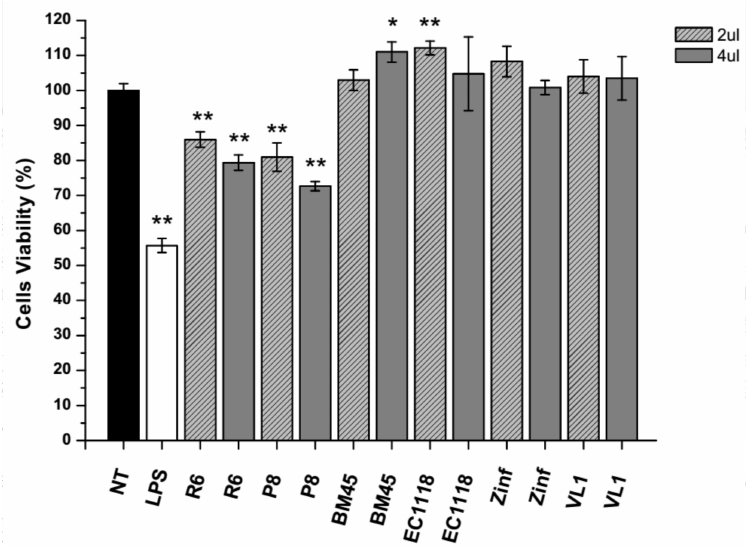
Figure 2. Effect of samples on cell viability. RAW 264.7 cells were treated with 2 and 4 µ L of the samples and subjected to an MTT test. Absorbance of formazan was determined at 595 nm and cell viability was reported as a percentage. A positive control ( (cid:3) ) was obtained by treating cells with lipopolysaccharide (LPS). Values from non-treated cells (NT) were used as a negative control ( (cid:4) ). Results are the mean of three different experiments performed in duplicate. Bars indicate S.D. (* p < 0.05; ** p < 0.001 vs. NT i.e., negative